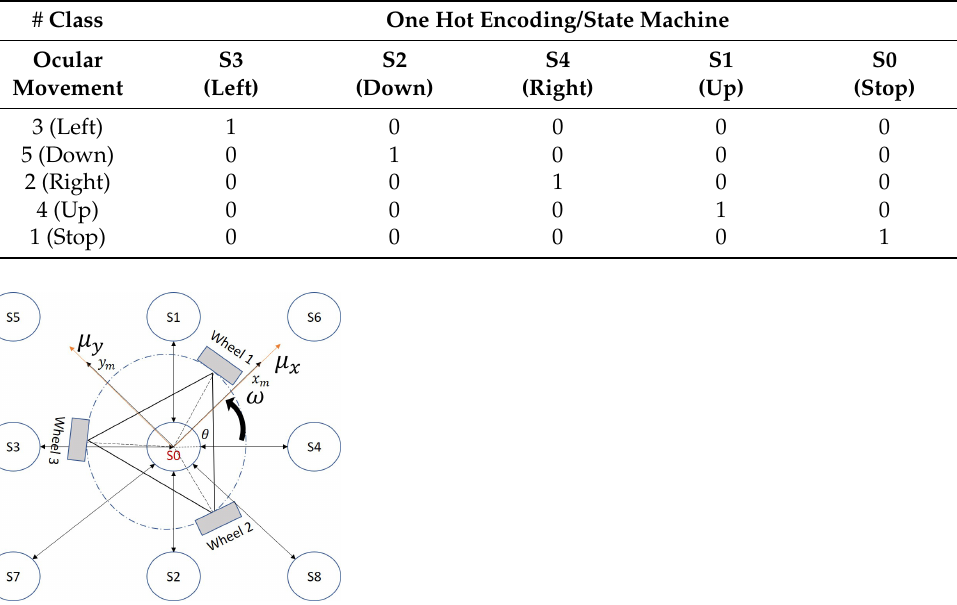
Table 2. Categorization by integers (one-hot encoding).